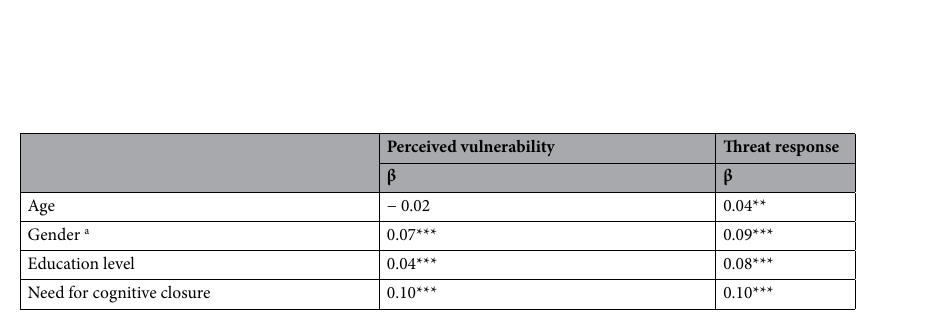
Table 3. Multilevel regression predicting perceived vulnerability and threat response by need for cognitive closure at the individual level. ** p < 0.01, *** p < 0.001. a Male = reference